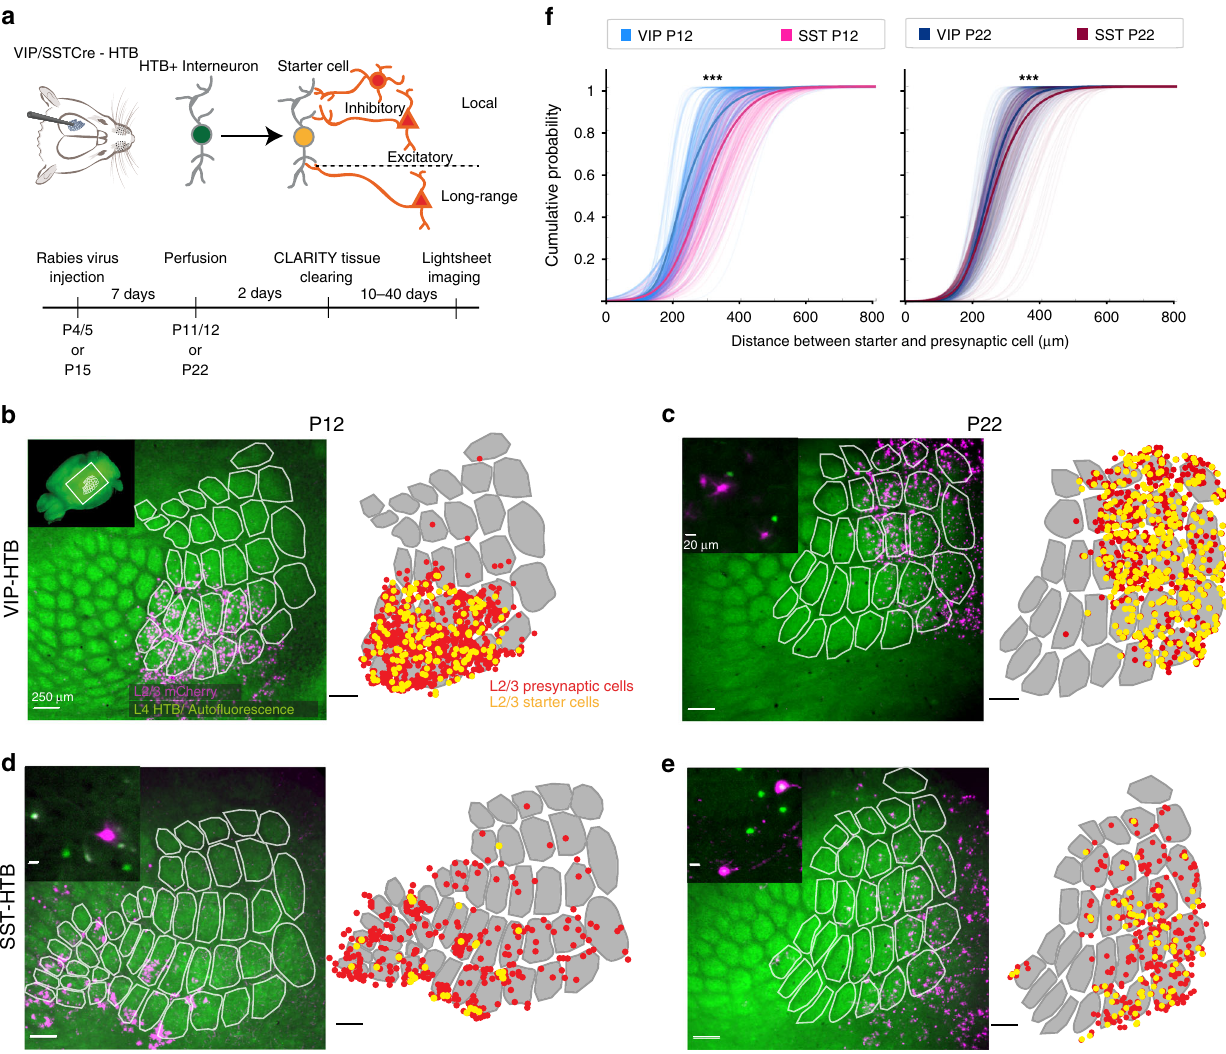
Fig. 2 Super fi cial VIP + and SST + interneurons show distinct barrel- fi eld afferent connectivity motifs. a Shematic representation of the experimental protocol. Rabies virus tracing was combined with tissue clearing and whole brain imaging. b – e Left: overlay of maximum intensity projection of L2/3 mCherry signal and median intensity projection of L4 auto fl uorescence after re-slicing of whole brain images. Right: Tranformation applied before distance analysis. Segmented barrels overlayed with L2/3 starter (yellow) and presynaptic (red) cells represented as dots. Inset in b indicates location of barrel fi eld in the whole brain. Insets in c – e show close-ups of rabies labelled neurons. (VIP P12, N = 4: 382 starter and 1943 presynaptic cells, SST P12, N = 6: 102 starter and 581 presynaptic cells, VIP P22, N = 5: 645 starter and 1561 presynaptic cells, SST P22, N = 4: 110 starter and 504 presynaptic cells). f Cumulative distribution of Euclidian distance in 2D between the starter cells and all presynaptic cells in a 800- μ m radius around them. The faint lines in the background depict the distance distribution of each starter cell; the thicker lines depict the average. Same number of animals and cells as in b , c . Statistics: two-sample Kolmogorov – Smirnov test, p (P12) = 8.410 × 10 − 7 , p (P22) = 3.628 × 10 − 6 . Source data are provided as a Source data fi